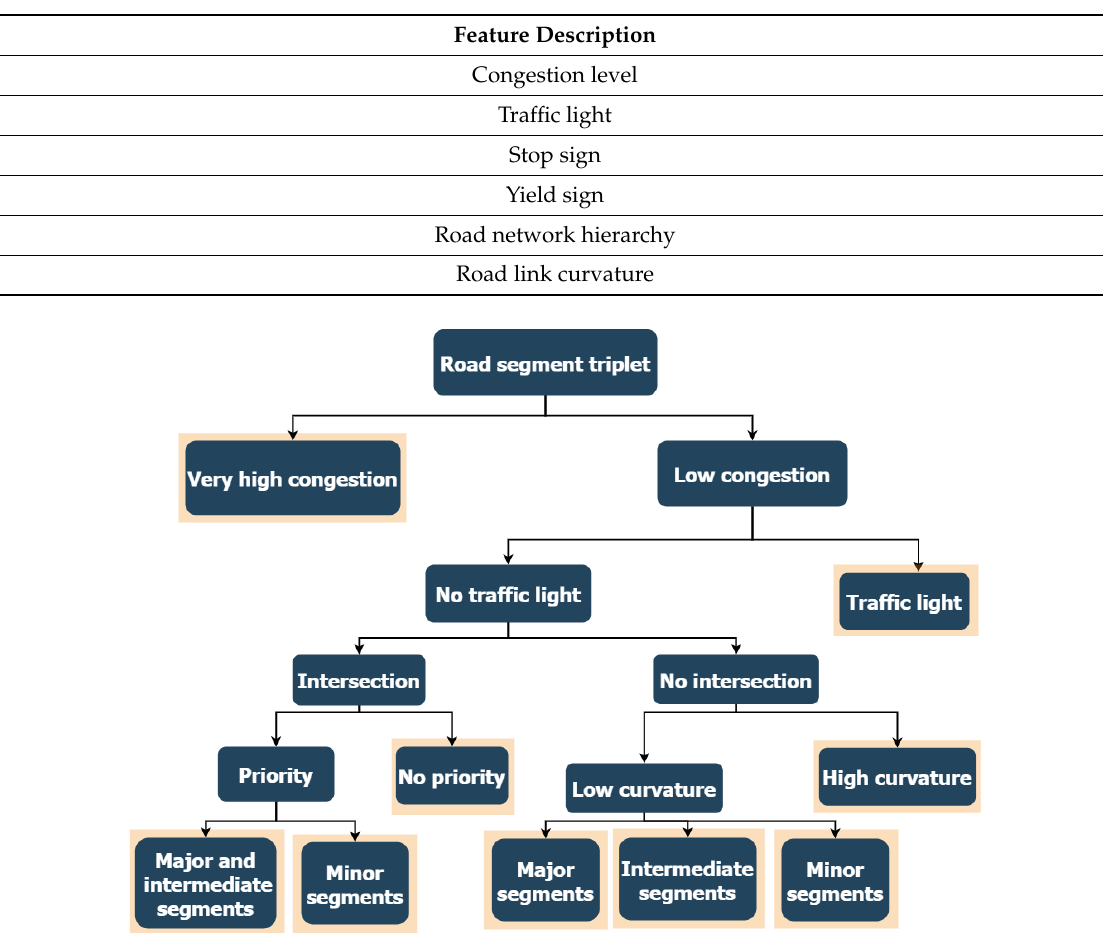
Table 1. Macroscopic features for the definition of categories.